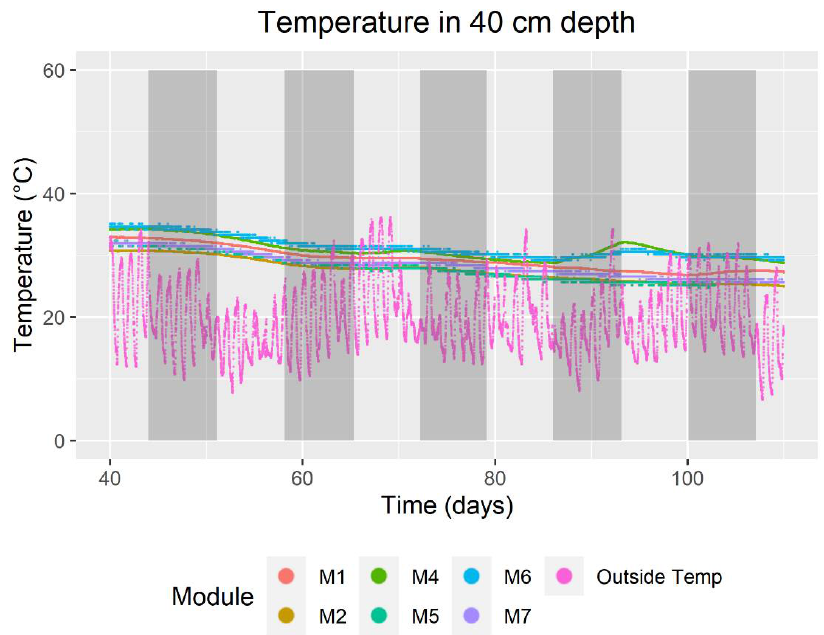
Figure 9. Temperature within 40 cm depth during the full-scale test within the trial field. Grey highlighted are the days of air breaches. Breaches 1–3 and 5 are at spot A, and breach 4 is at spot B (Figure 2). Over the whole storage period (300 days) the temperature decreased with a bigger exemption of Module M4 and M6 at days 86–93. Additionally, other modules showed slight increases in temperature when hot days preceded. As Module 8 broke within the first few days, it is not